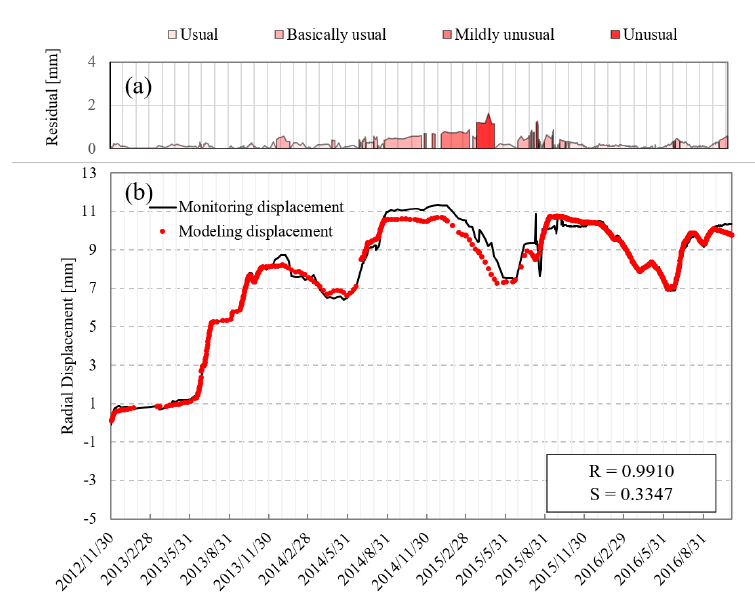
Figure 8. Time variation of ( a ) classified residual and ( b ) modelled and monitored displacement data for the monitoring point PL9-5.